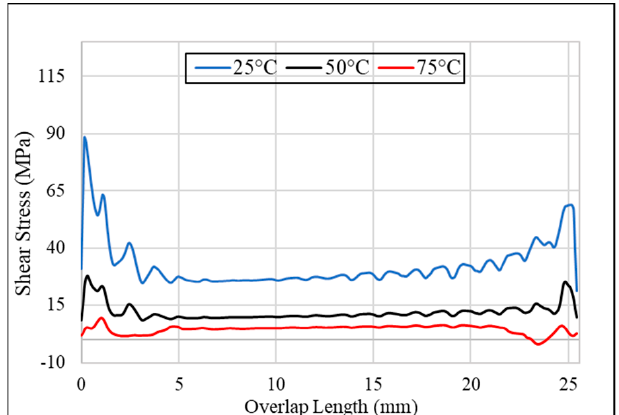
Figure 21. Shear stress distribution at location D of SLJ with Al 2 O 3 nanoparticles in the adhesive at different temperatures.